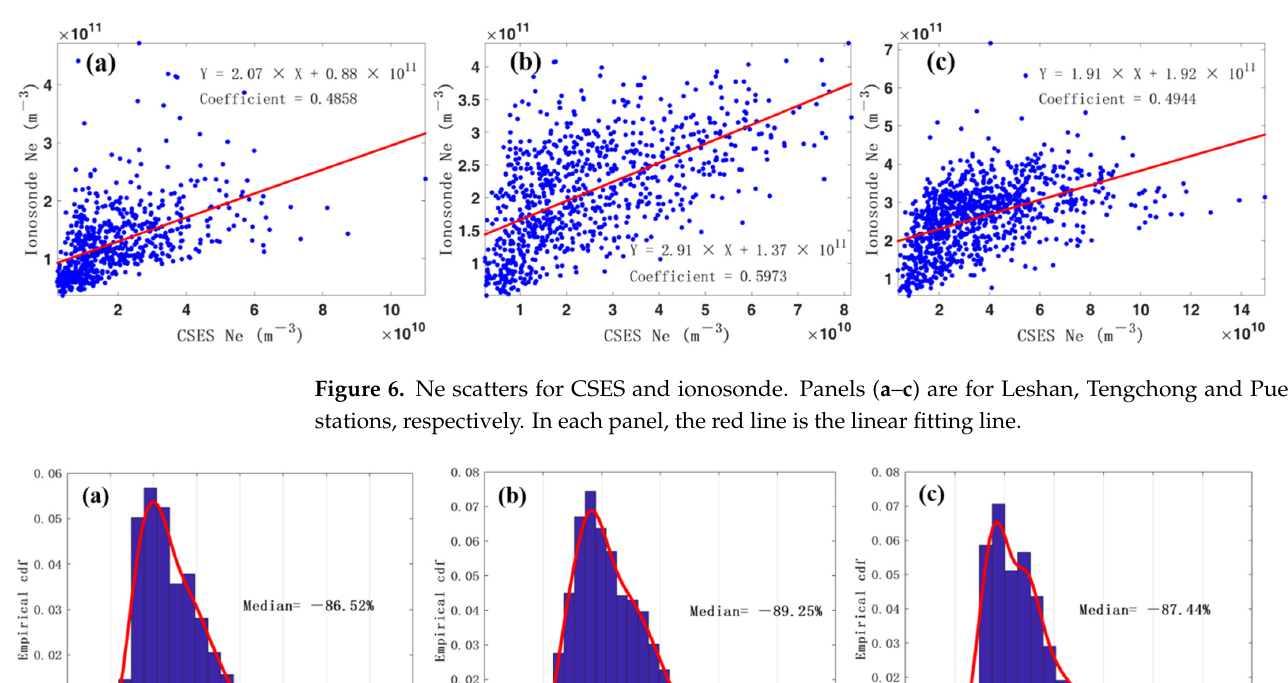
dotted line denotes Ne at the satellite altitude inferred by ionosonde observations and IRI model. Red and blue lines are the 15-day running mean.